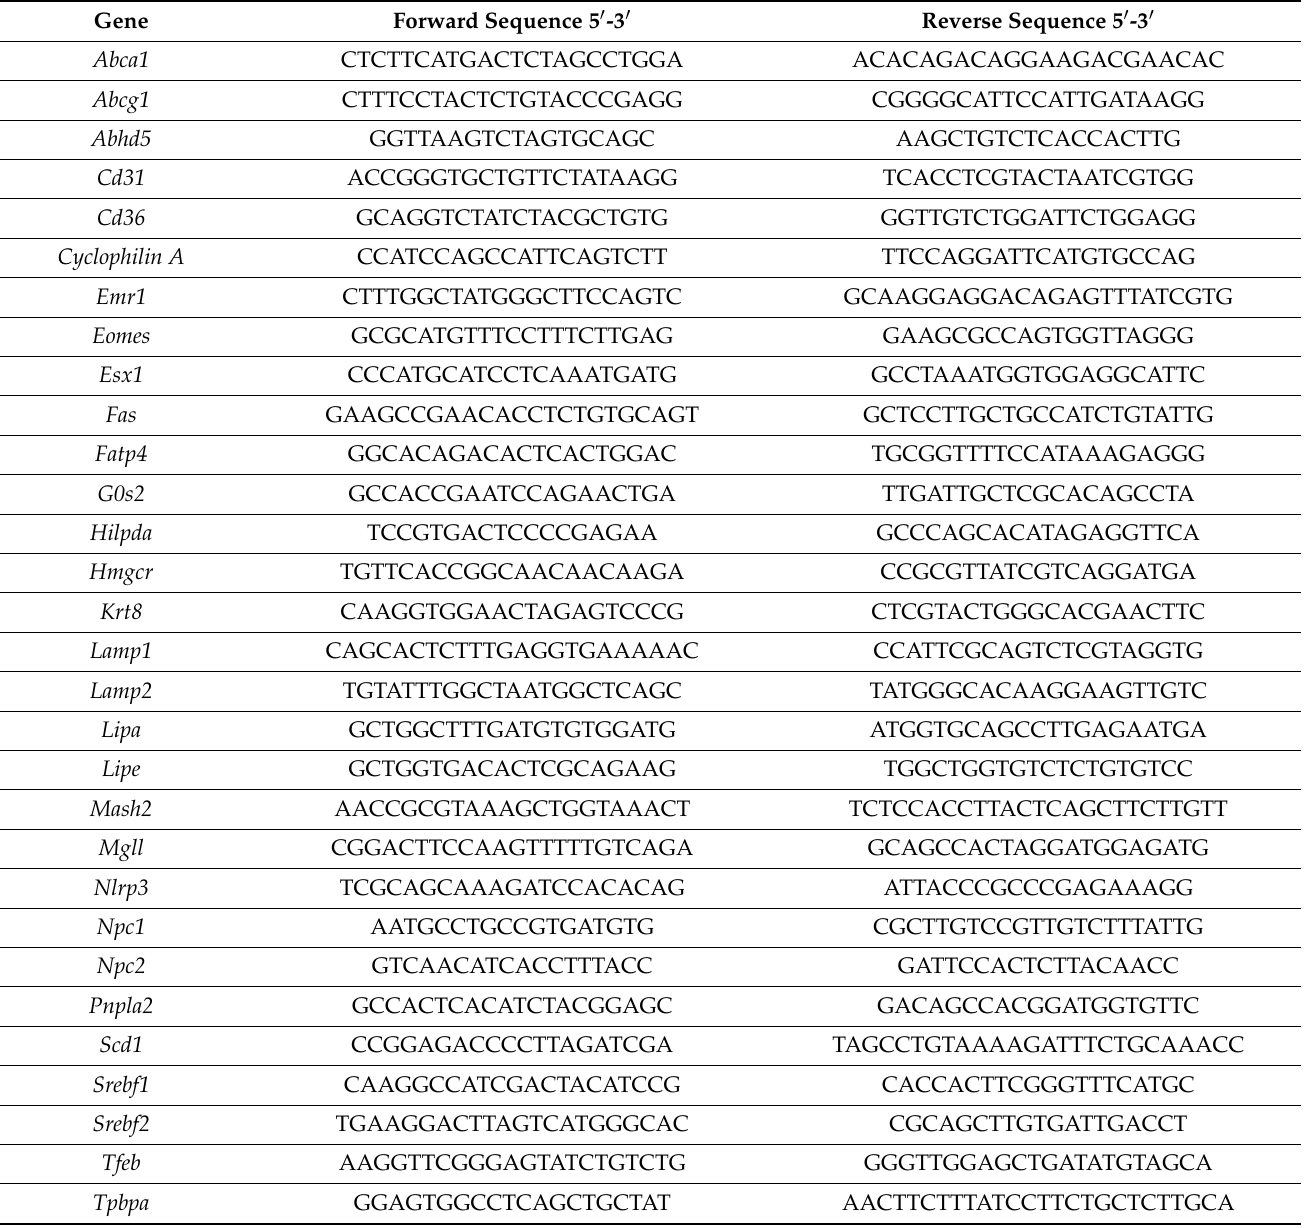
Table 1. Primers used for real-time